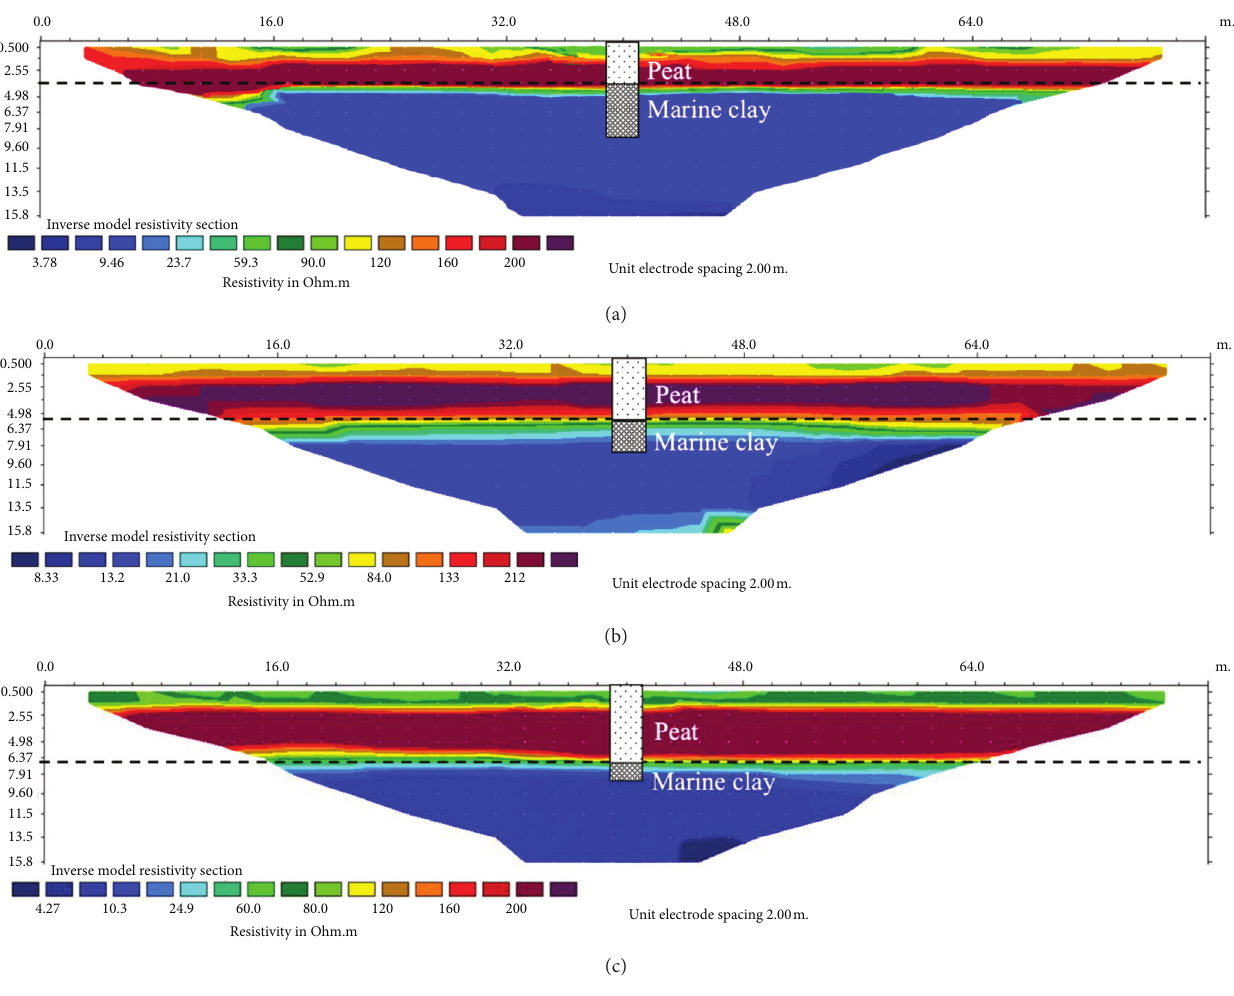
Figure 6: 2D resistivity images: (a) S1, (b) S2, and (c) S3.